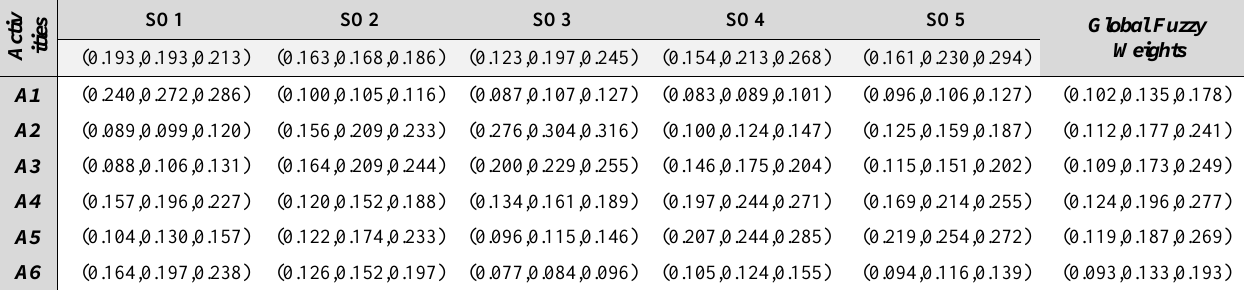
Table 5. Local and global fuzzy weights of the activities obtained by the modified fuzzy LLSM ti v iti e A c